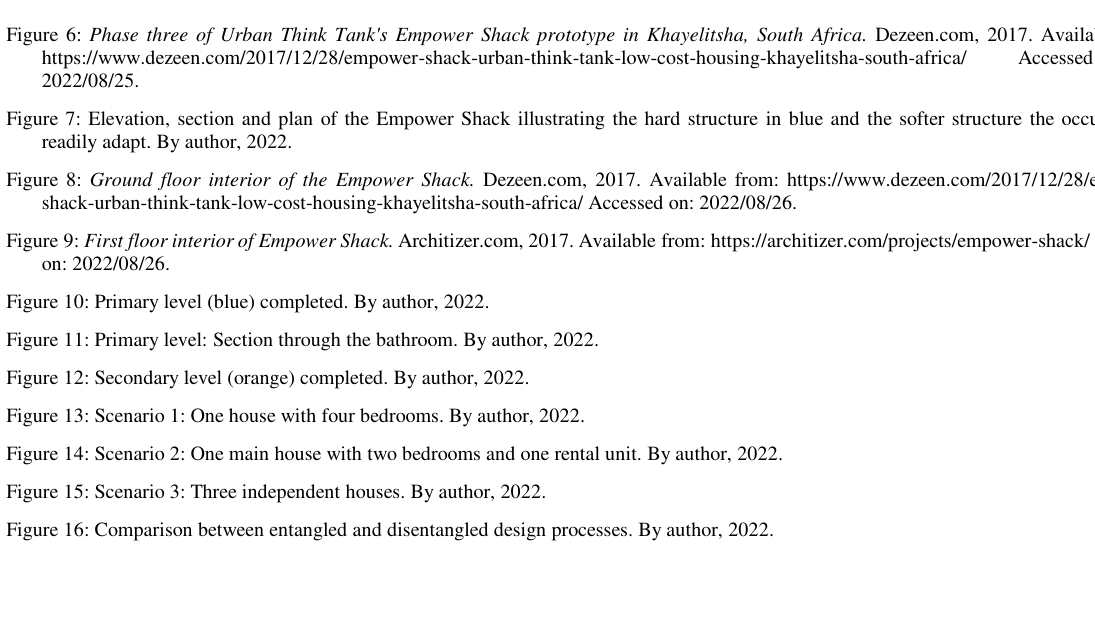
Figure 6: Phase three of Urban Think Tank's Empower Shack prototype in Khayelitsha, South Africa. Dezeen.com, 2017. Available from: https://www.dezeen.com/2017/12/28/empower-shack-urban-think-tank-low-cost-housing-khayelitsha-south-africa/ Accessed on: 2022/08/25. Figure 7: Elevation, section and plan of the Empower Shack illustrating the hard structure in blue and the softer structure the occupant can readily adapt. By author, 2022. Figure 8: Ground floor interior of the Empower Shack. Dezeen.com, 2017. Available from: https://www.dezeen.com/2017/12/28/empower- shack-urban-think-tank-low-cost-housing-khayelitsha-south-africa/ Accessed on: 2022/08/26. Figure 9: First floor interior of Empower Shack. Architizer.com, 2017. Available from: https://architizer.com/projects/empower-shack/ Accessed on: 2022/08/26. Figure 10: Primary level (blue) completed. By author, 2022. Figure 11: Primary level: Section through the bathroom. By author, 2022. Figure 12: Secondary level (orange) completed. By author, 2022. Figure 13: Scenario 1: One house with four bedrooms. By author, 2022. Figure 14: Scenario 2: One main house with two bedrooms and one rental unit. By author, 2022. Figure 15: Scenario 3: Three independent houses. By author, 2022. Figure 16: Comparison between entangled and disentangled design processes. By author,